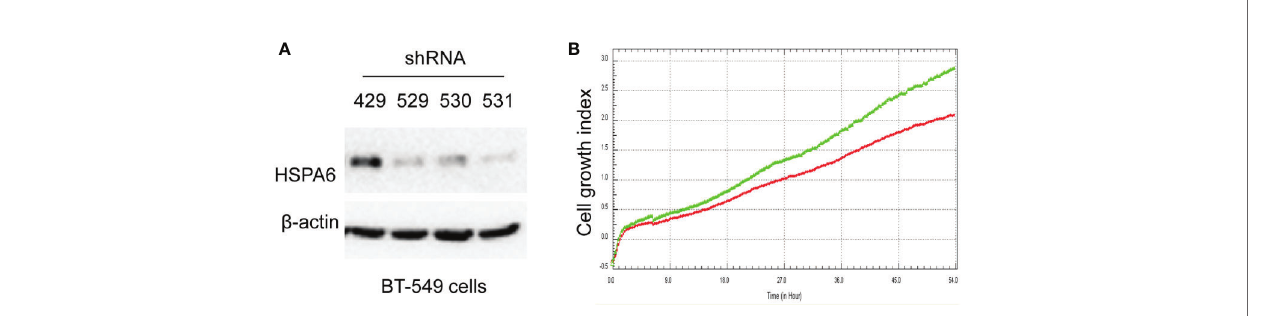
FIGURE 3 | Knocking down HSPA6 promotes cancer cell growth. (A) Knocking down HSPA6 in TNBC cell line BT-549. Clones 529, 530, and 531 show the ef fi ciency for knocking down of HSPA6, and clone 531 shows more ef fi ciency; whereas clone 429 shows the empty vector control without knocking down. (B) Cell growth. Red lines, controls; green lines, knocking down HSPA6.